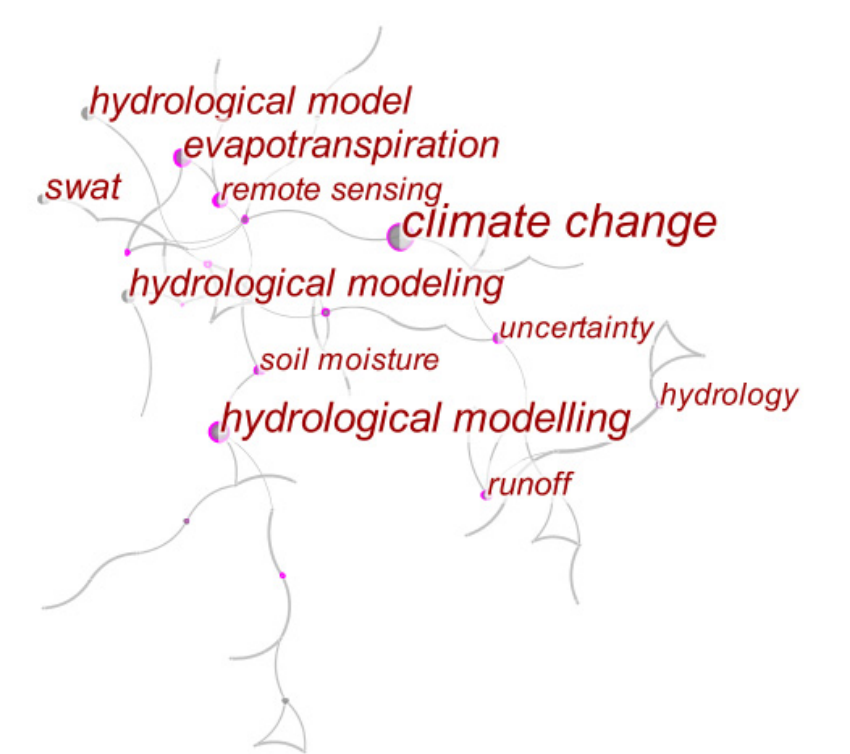
Figure 9. Keyword co-occurrence map from January to October 2020.